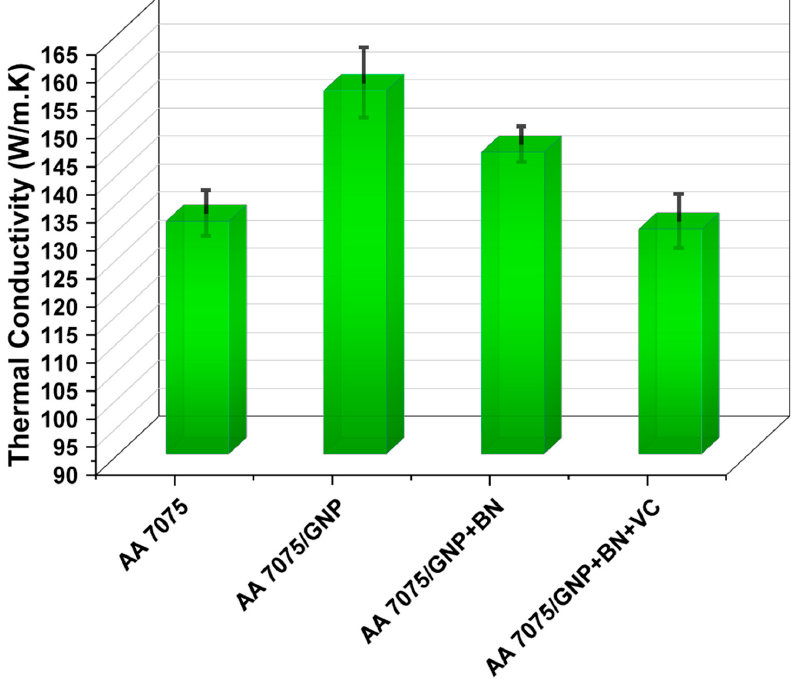
Figure 6. Thermal conductivity of the base alloy AA7075, fabricated monocomposite AA7075/GNPs, and hybrid composite matrices.